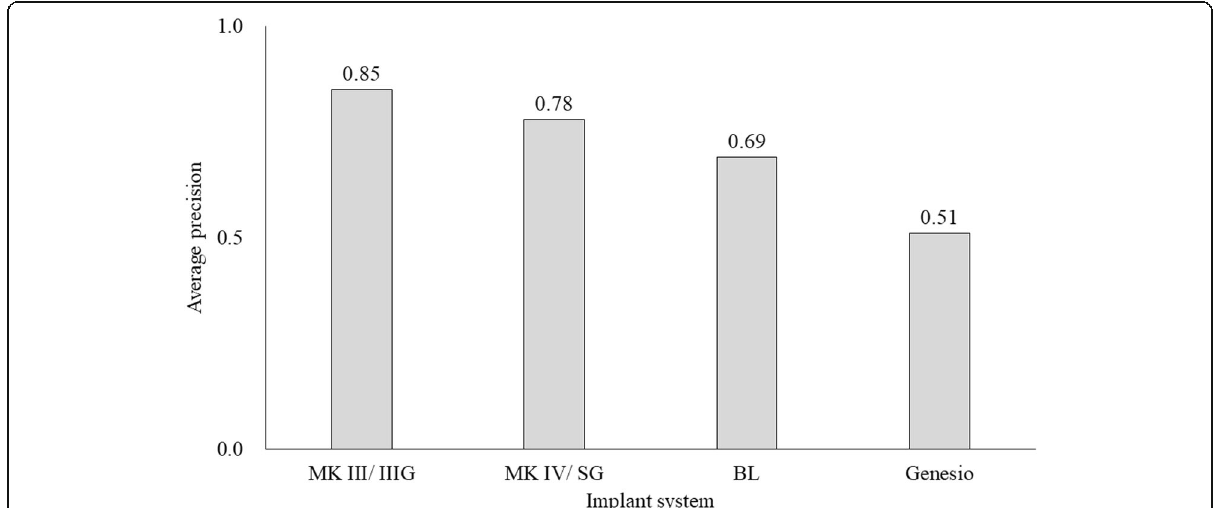
Fig. 5 Average precision (AP) of each implant system in all images. MK III/MK III Groovy: MK III/IIIG, MK IV/Speedy Groovy: MK IV/SG, bone level: BL and Genesio Plus ST: Genesio